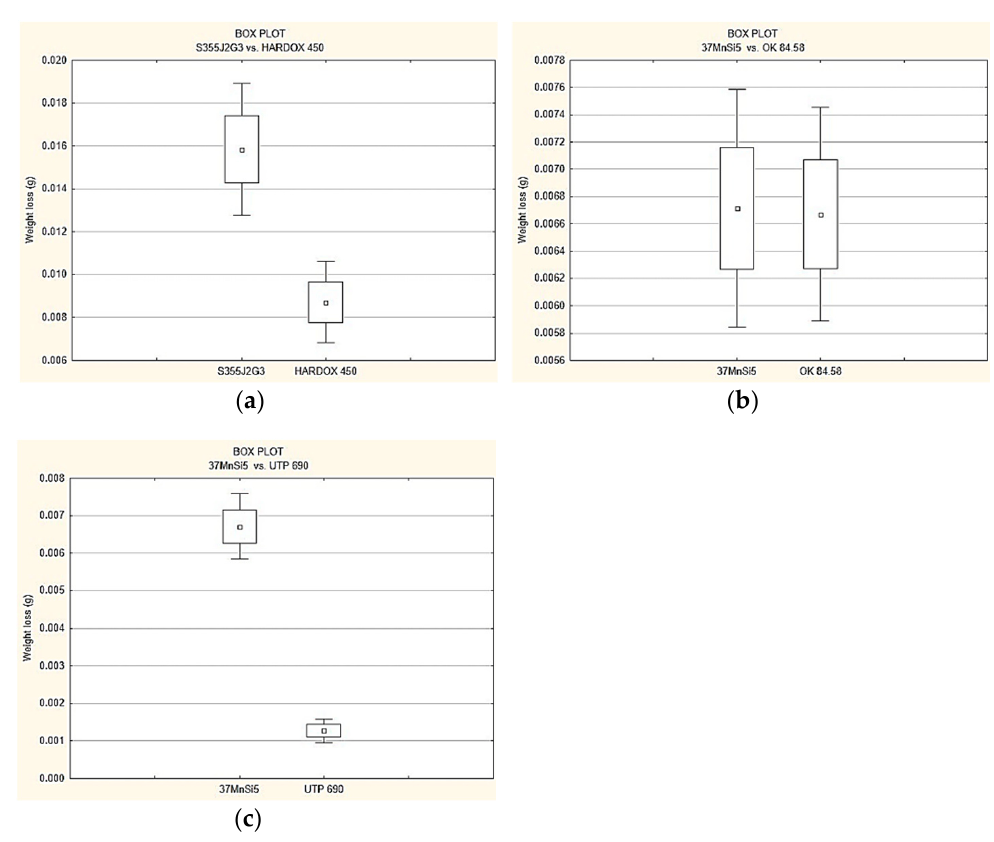
Figure 11. Box charts: ( a ) weight loss of S355J2G3 and HARDOX 450 materials; ( b ) weight loss of 37MnSi5 material and OK 84.58 hardfacing material; and ( c ) weight loss of 37MnSi5 material and UTP 690 hardfacing material.